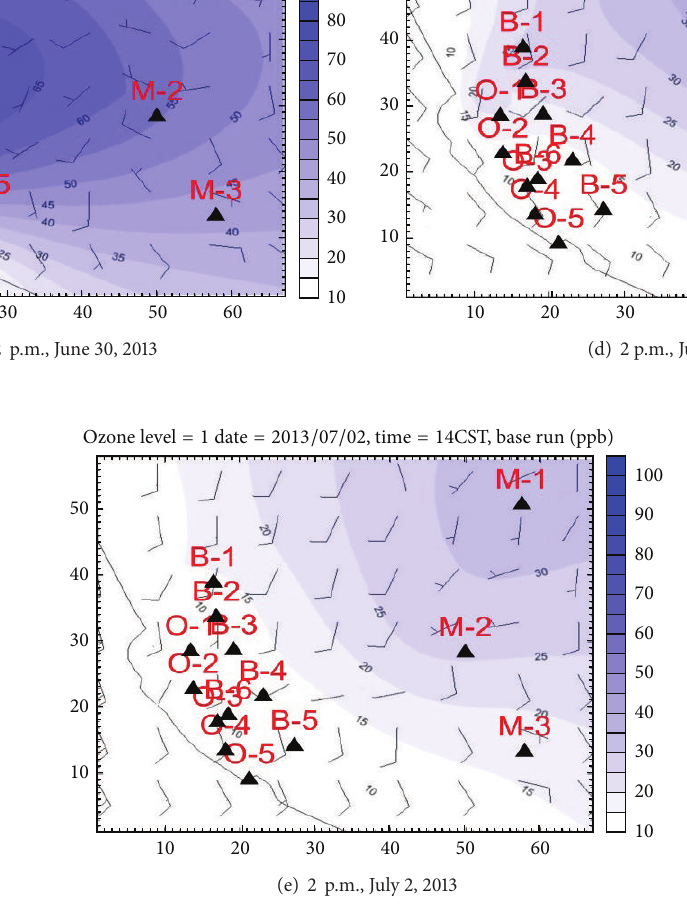
Figure 9: Simulated surface O 3 concentration couture and wind vector in Southwestern Taiwan area (O 3 concentration unit: